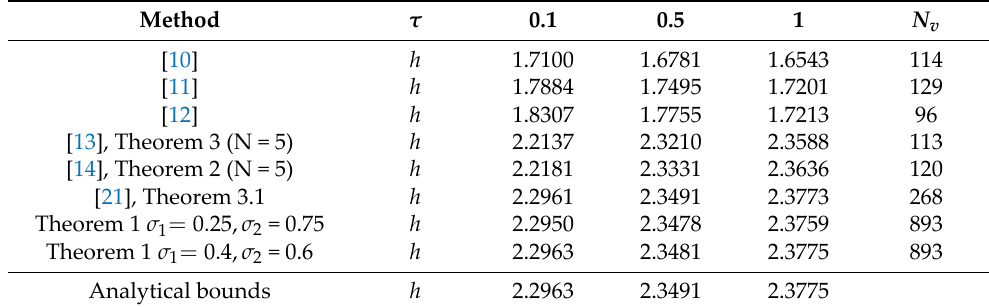
Table 1. Maximum Upper Bounds of h for Different τ